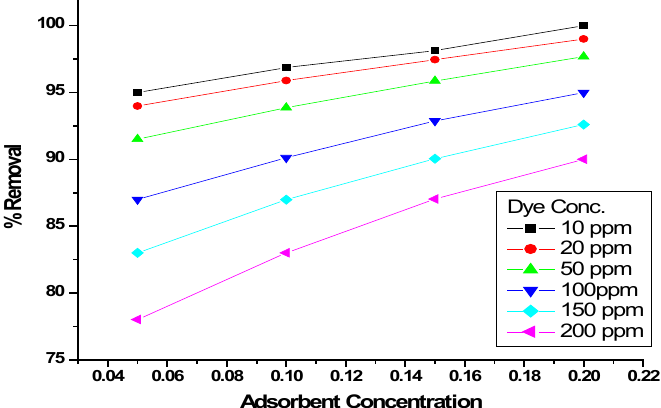
Fig. 4: Adsorbent concentration variation study